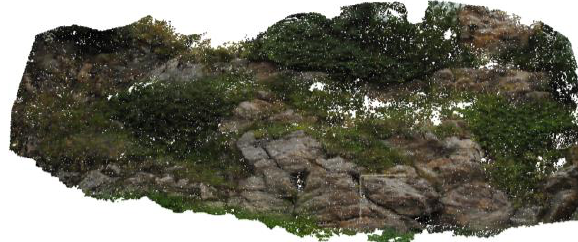
Figure 14. Pix4D Nikon dense point